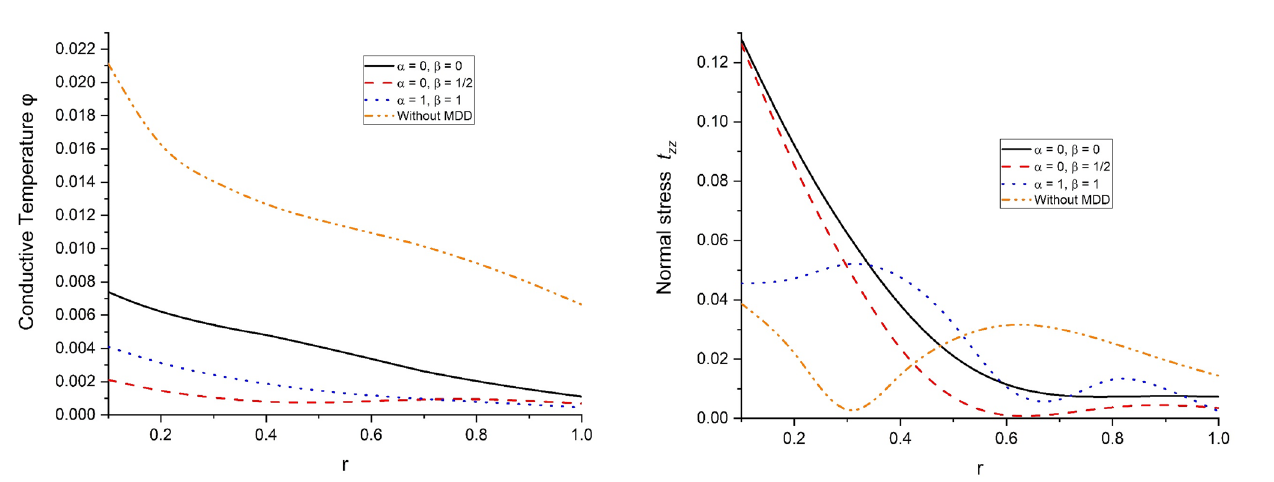
(iii) The dotted blue line corresponds to